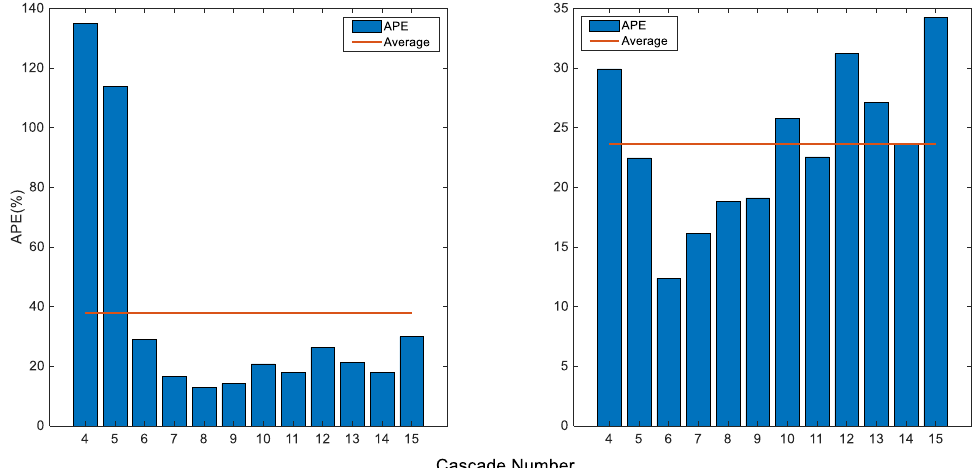
Figure 15. E ff ect of preprocessing with respect to cascade number. ( Left ): without preprocessing. Figure 15. Effect of preprocessing with respect to cascade number. Left : without preprocessing. Right : ( Right ): with with preprocessing.